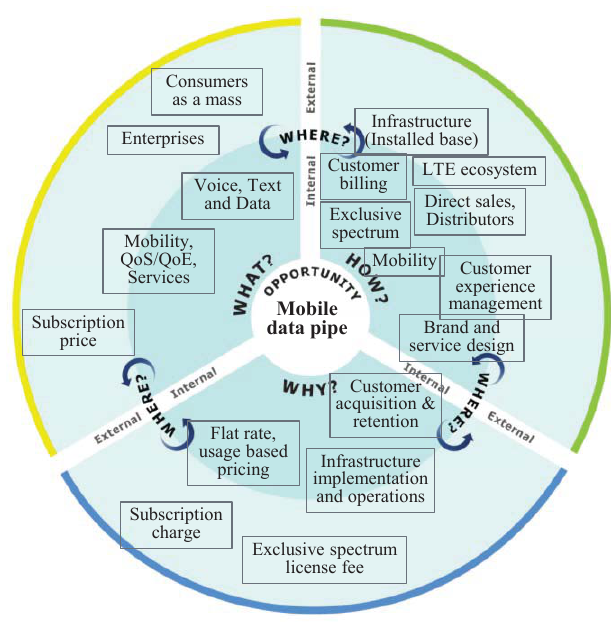
Figure 4. MNO’s “Mobile data pipe” business model in the traditional exclusive license case.